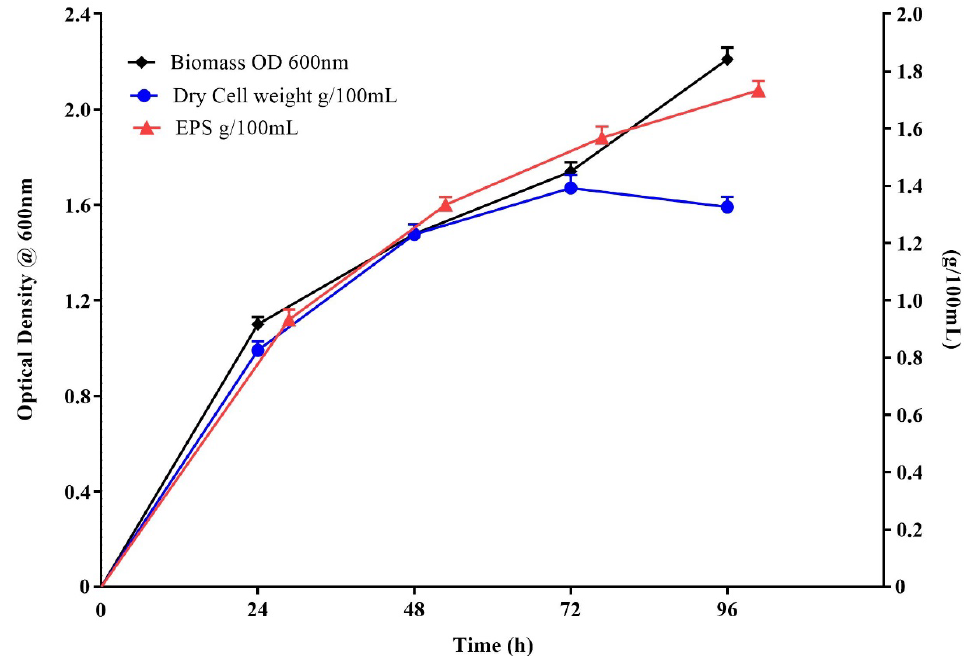
Figure 1. Biomass optical density (OD), the cellular dry weight (CDW), and exopolysaccharide (EPS) production as a function of time. Virgibacillus dokdonensis VITP14. Values are means and error bars indicate standard deviations ( n = 3). Table 1. Exopolysaccharide (EPS) production on Zobell marine broth by VITP14. S.